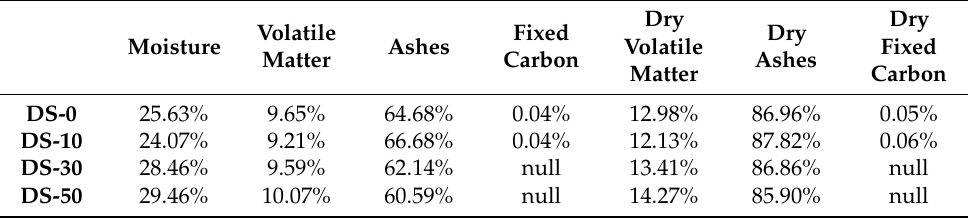
Table 4. Results from the static thermogravimetric analysis for the different brick mixtures.